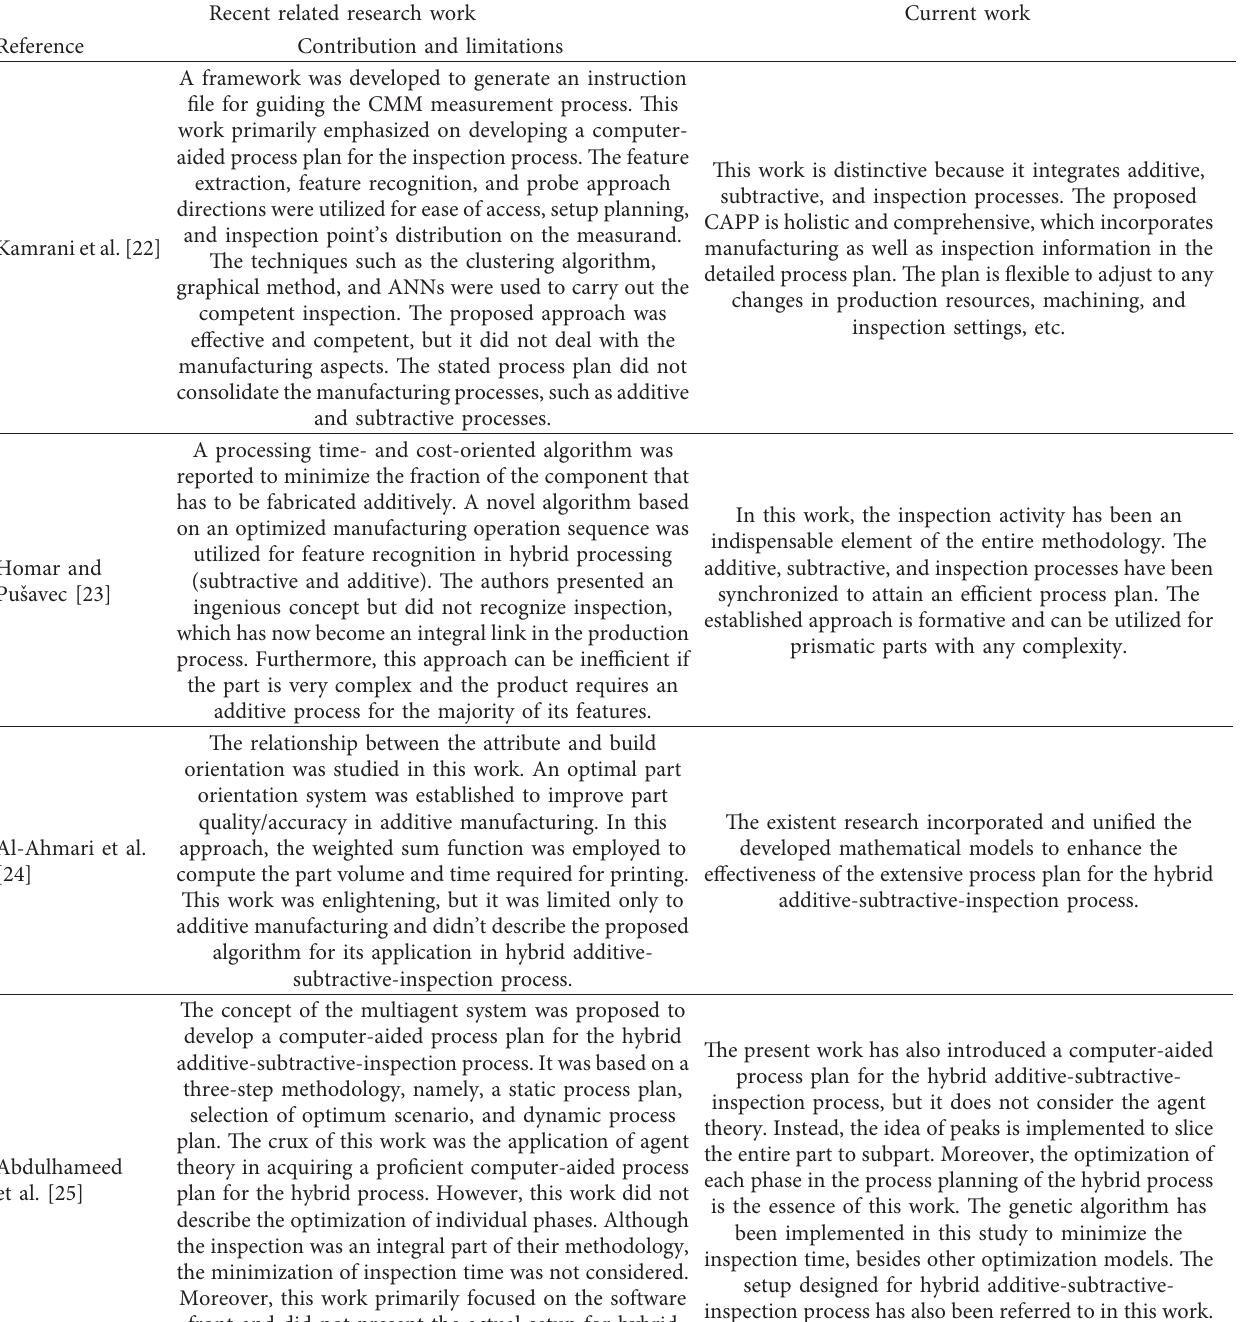
Table 1: Distinction of present contribution in comparison to recent related